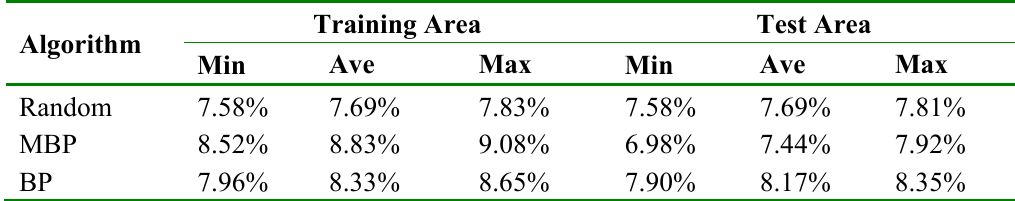
Table 9. Statistical results of different algorithms (Maximum iterations = 2,000).